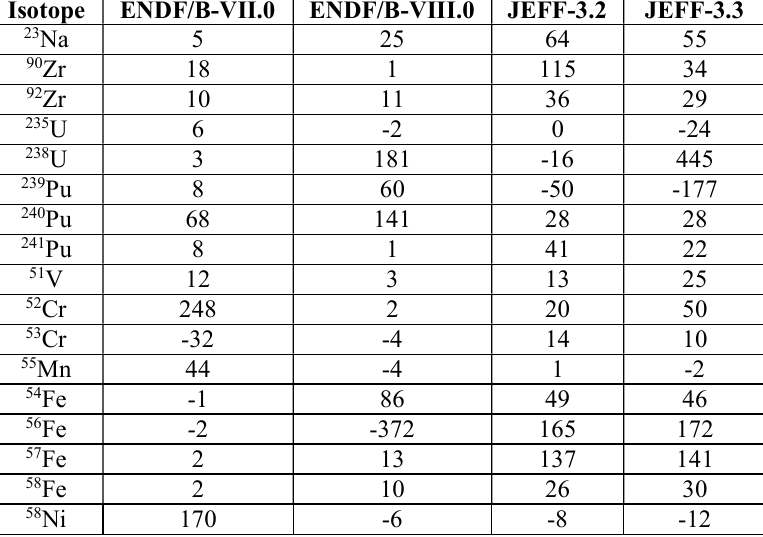
Table II. Isotopic Substitutions: Reactivity differences [pcm] from reference ENDF/B-VII.1